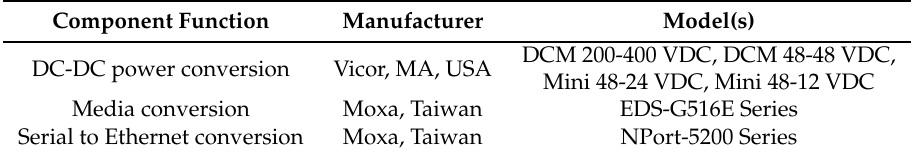
Table A1. Key integration hub components.